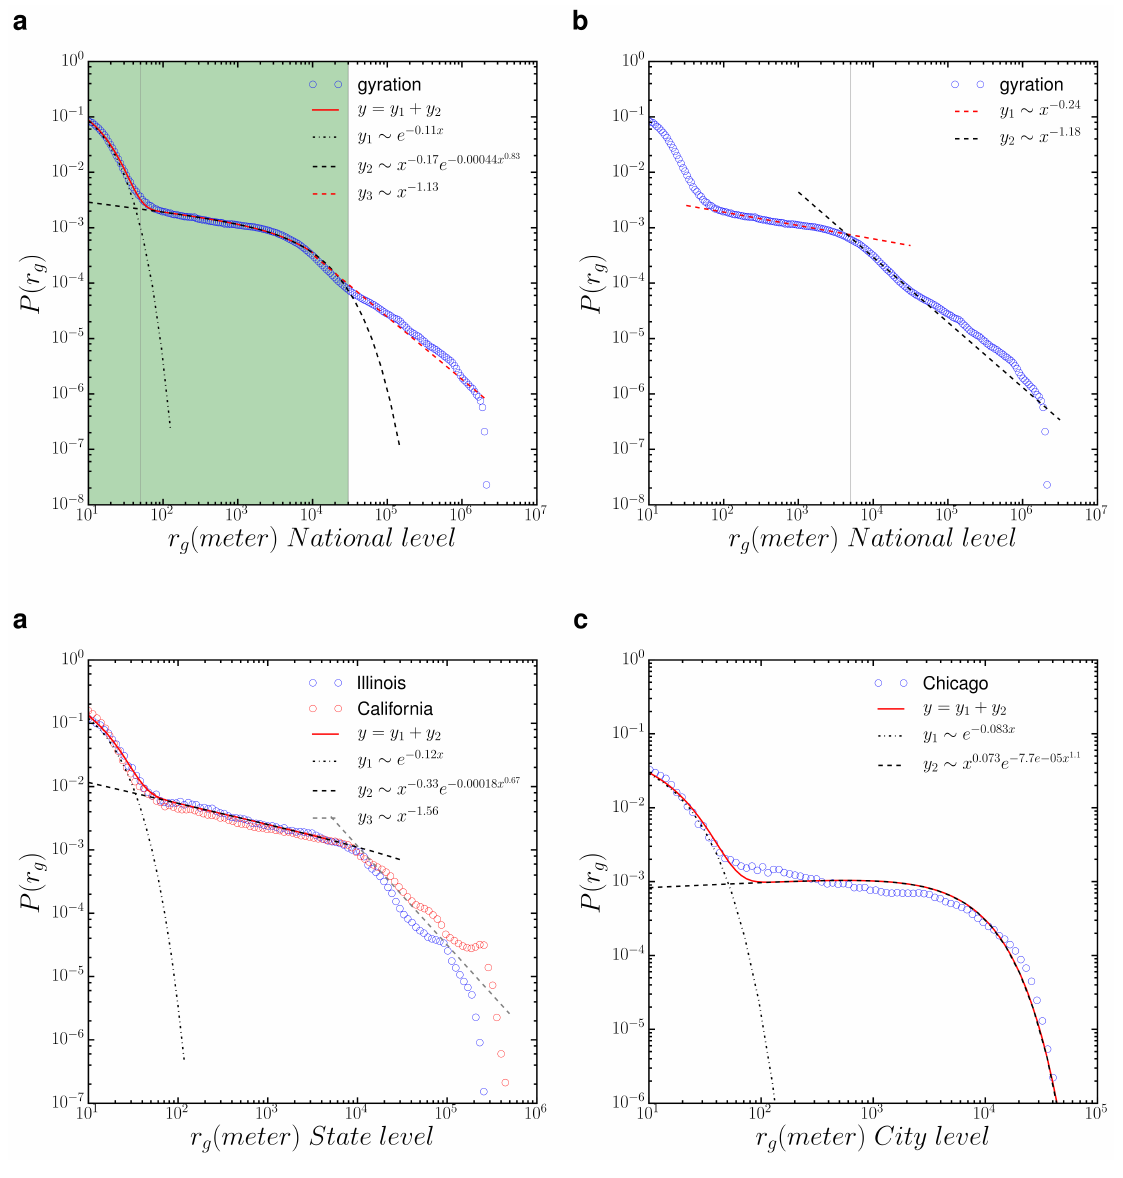
Figure 5. ( a ) The probability distribution of radius of gyration of individual Twitter users P( r g ) at the national level; ( b ) the distance between [50 m, 30 km] is approximated by a double power-law functions; ( c ) P( r g ) at the state level (Illinois and California); ( d ) P( r g ) for Chicago